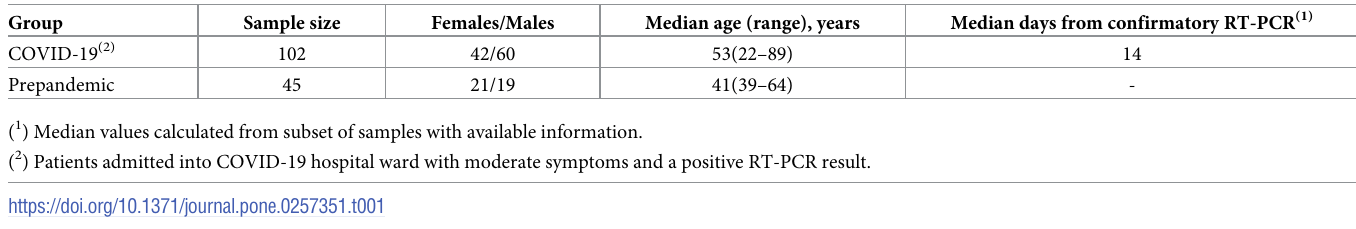
Table 1. Summary of samples used in this